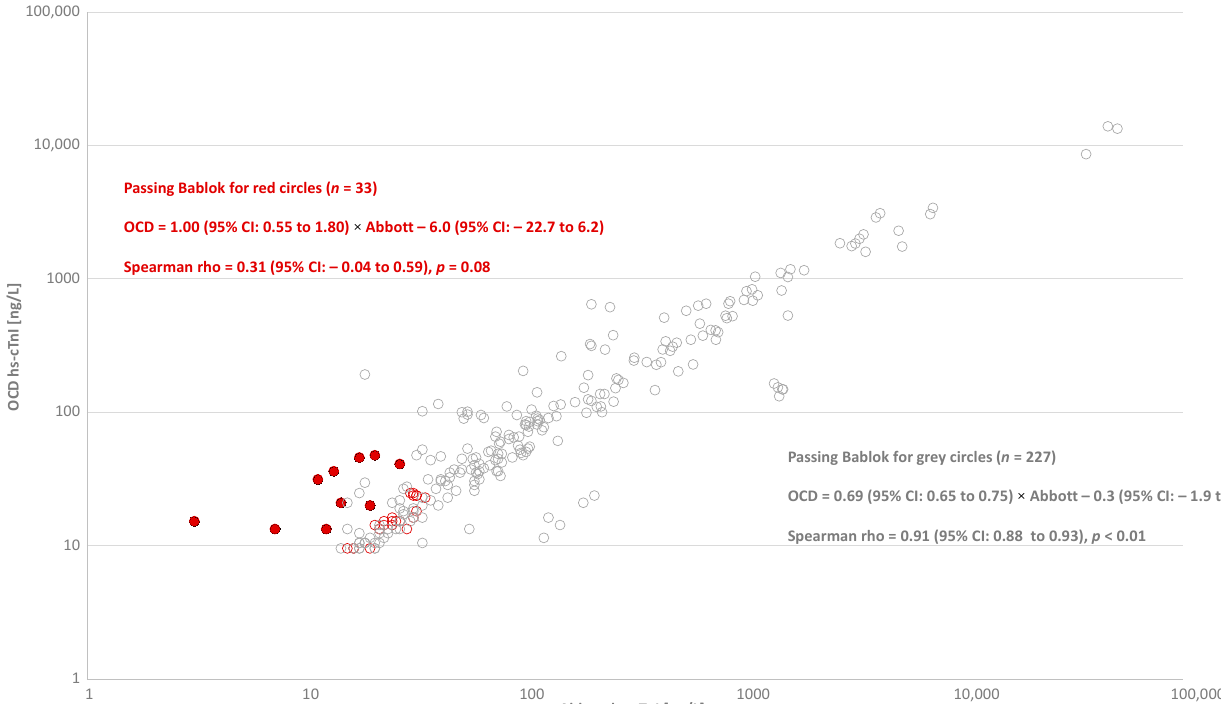
Figure 3. In 260 ethylenediaminetetraacetic acid (EDTA) plasma samples from the emergency department (ED) that yielded results for OCD hs-cTnI above the sex-specific 99th percentile URL cutoffs (i.e., positive results), the correlation between OCD hs-cTnI and Abbott hs-cTnI in samples where Abbott hs-cTnI values are above the URLs is indicated by the grey open circles ( n = 227). The red circles represent paired results where Abbott hs-cTnI levels are normal ( n = 33), with the red full circles representing paired results where OCD hs-cTnI is higher than Abbott hs-cTnI ( n = 10).